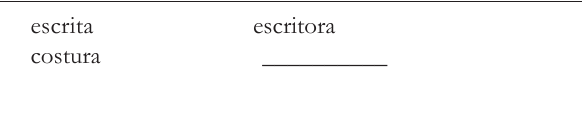
Figura 7. Exemplo de item da tarefa de analogia de